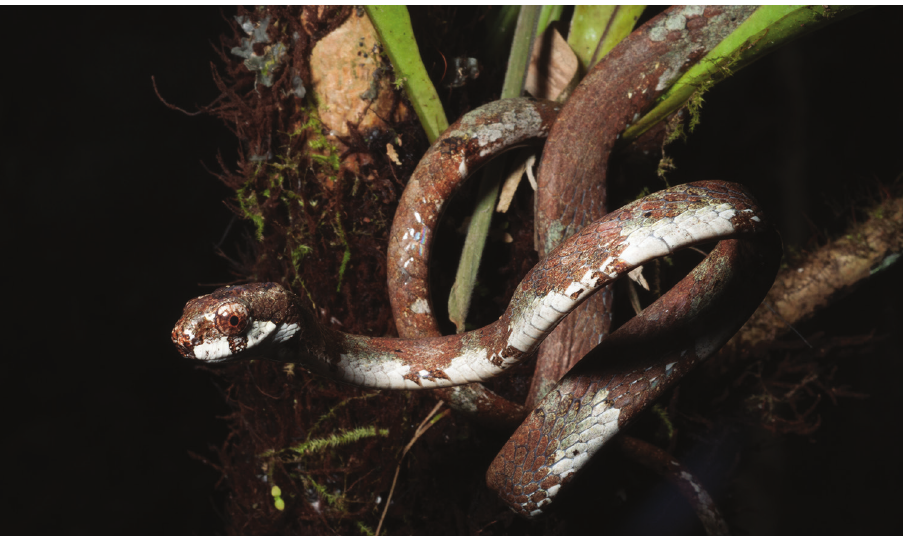
Figure 77. Aplopeltura boa (KU 334473) from Eye Falls, Mt. Hilong-hilong, Municipality of Remedios T. Romualdez, Agusan del Norte Province. Photo: